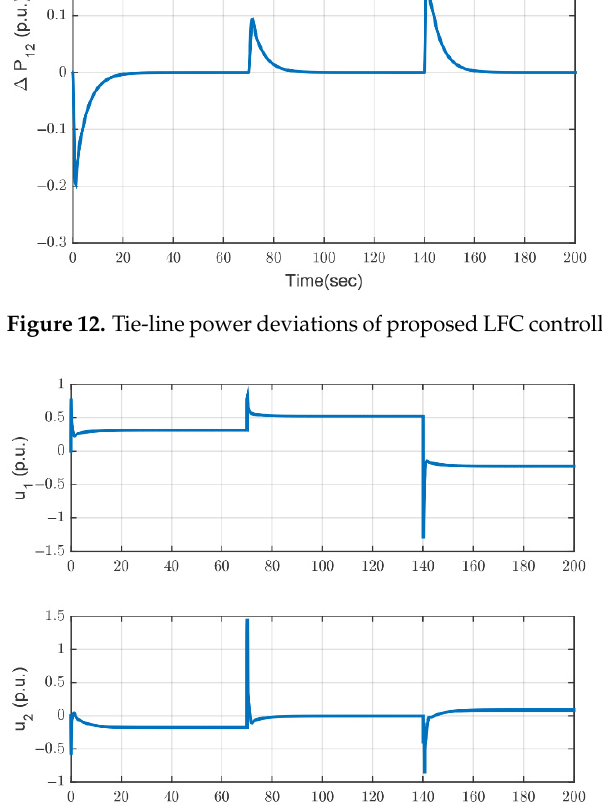
Figure 13. Control input for the random step load disturbance.